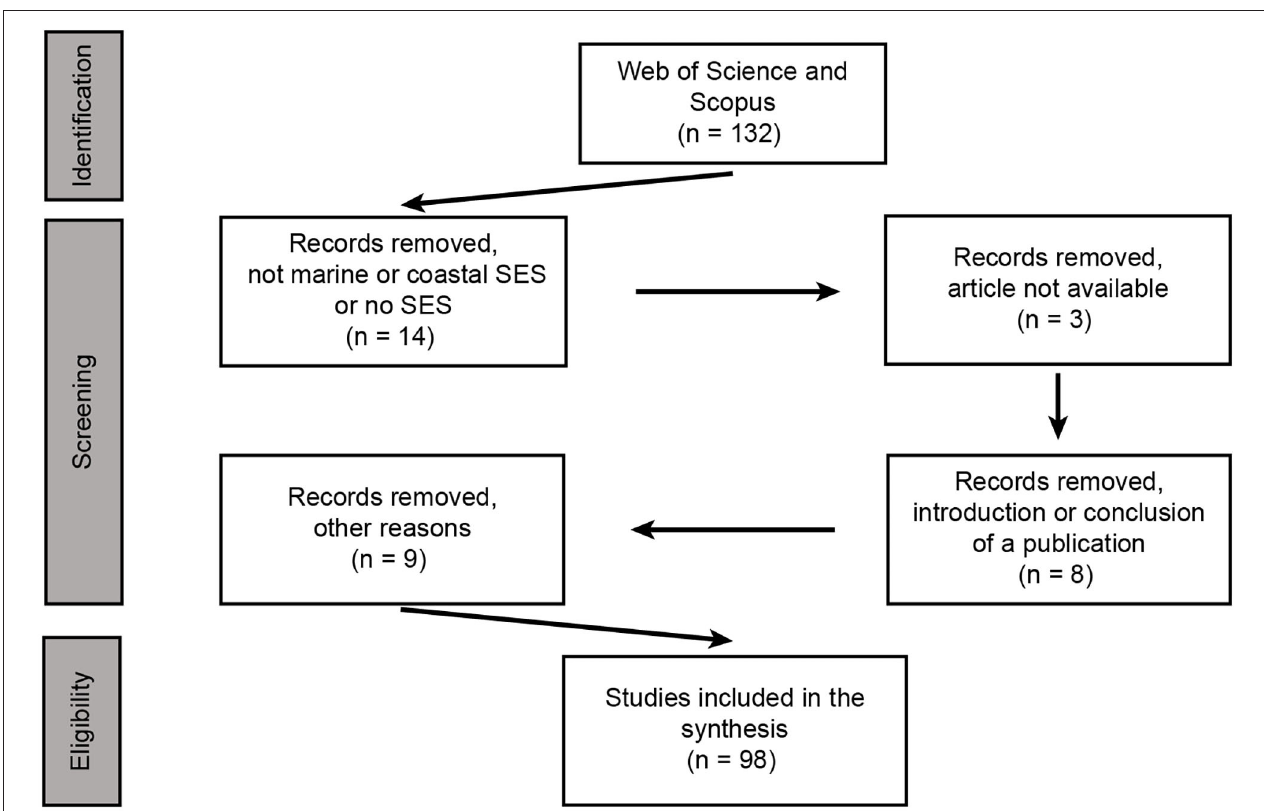
FIGURE 1 | Screening process of the literature sample on coastal and marine socio-ecological